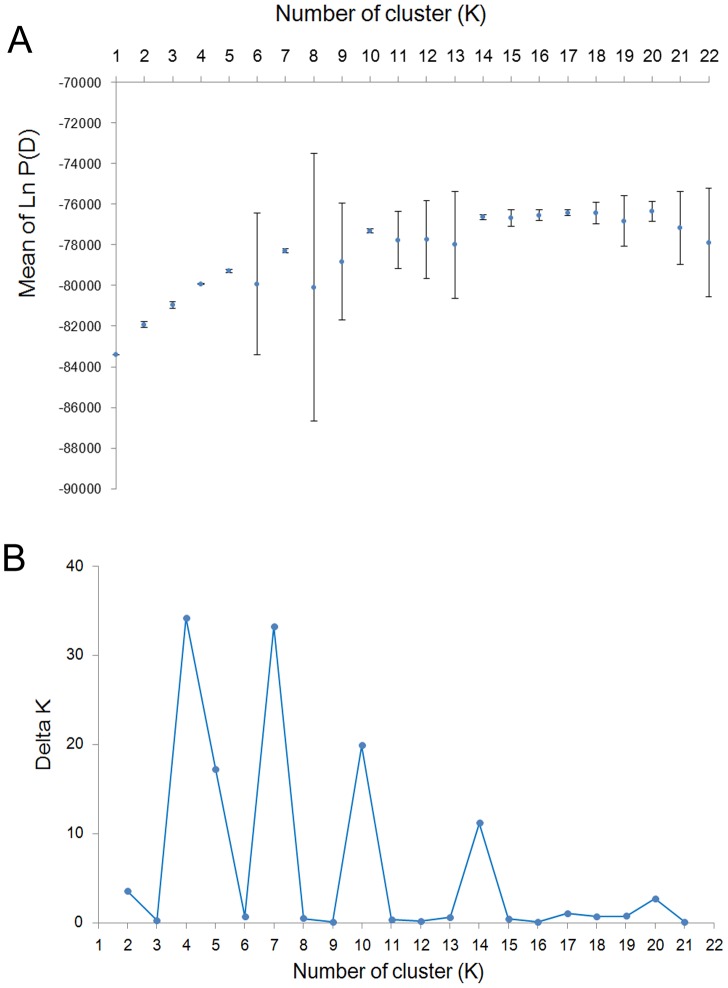
Plot of the Ln P(D) ± SD and delta K (ΔK).The mean of Ln P(D) was based on ten repetitions for each K value.